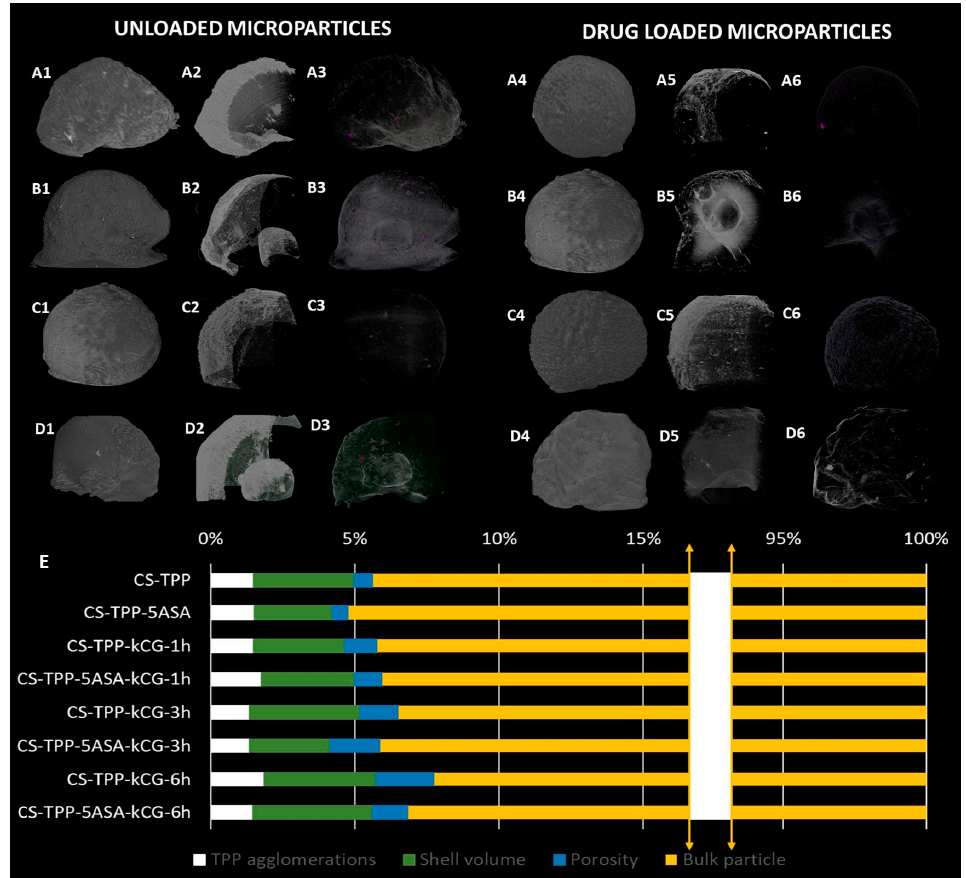
Figure 9. Morphological characterization by means of µCT of the unloaded ( A1–A3 , D1–D3 ) and drug-loaded ( A4 – A6 , D4 – D6 ) microparticles, while in the ( E ) section of the image the volume ratios of TPP particles in white, shell volume in green, porosity in blue and the rest of the particulate specimen in yellow are plotted. In the dataset, full volume of the drug free particle is depicted for ( A1 ) CS-TPP, ( B1 ) CS-TPP-kCG-1h, ( C1 ) CS-TPP-kCG-3h, ( D1 ) CS-TPP-kCG-6h. In the section, cross-sectional views for the visualization of the particles polymeric shell is illustrated for ( A2 ) CS-TPP, ( B2 ) CS-TPP-kCG-1h, ( C2 ) CS-TPP-kCG-3h, ( D2 ) CS-TPP-kCG-6h. In the subdivision, TPP agglomeration within the microparticle volume is preferentially illustrated for ( A3 ) CS-TPP, ( B3 ) CS-TPP-kCG-1h, ( C3 ) CS-TPP-kCG-3h, ( D3 ) CS-TPP-kCG-6h. Meanwhile, in the dataset, full volume of the drug-loaded particle is depicted for ( A4 ) CS-TPP-5ASA, ( B4 ) CS-TPP-5ASA-kCG-1h, ( C4 ) CS- TPP-5ASA-kCG-3h, ( D4 ) CS-TPP-5ASA-kCG-6h. In the ( A5 – D5 ) section, cross-sectional views for the visualization of the particles polymeric shell is illustrated for ( A5 ) CS-TPP-5ASA, ( B5 ) CS-TPP-5ASA- kCG-1h, ( C5 ) CS-TPP-5ASA-kCG-3h, ( D5 ) CS-TPP-5ASA-kCG-6h. In the ( A6 – D6 ) subdivision, TPP ( B6 ) CS-TPP-5ASA-kCG-1h, ( C6 ) CS-TPP-5ASA-kCG-3h, ( D6 )